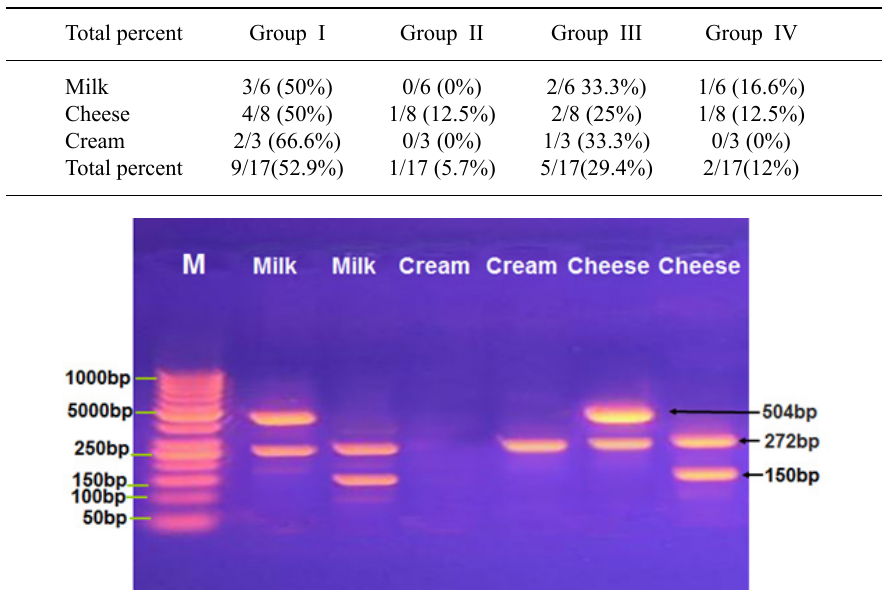
Fig. 1. Shows amplification of enterotoxin genes, sea , seb , and seg at product sizes of 504, 272, and 150bp respectively. Ladder is